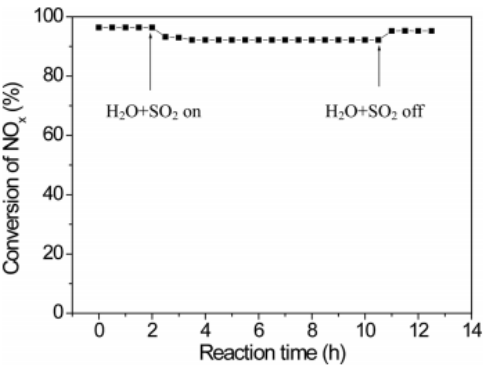
Figure 25. Response of the NO x conversion over Mn 0.2 Ce 0.1 Ti 0.7 O x catalyst at 200 °C to the intermittent feed of H 2 O and SO 2 (Reaction condition: 500 ppm of NO, 500 ppm of NH 3 , 5% O 2 , 5% H 2 O, 50 ppm of SO 2 , balance He, GHSV = 64,000 h − 1 ). (Reproduced with permission from Reference [46],